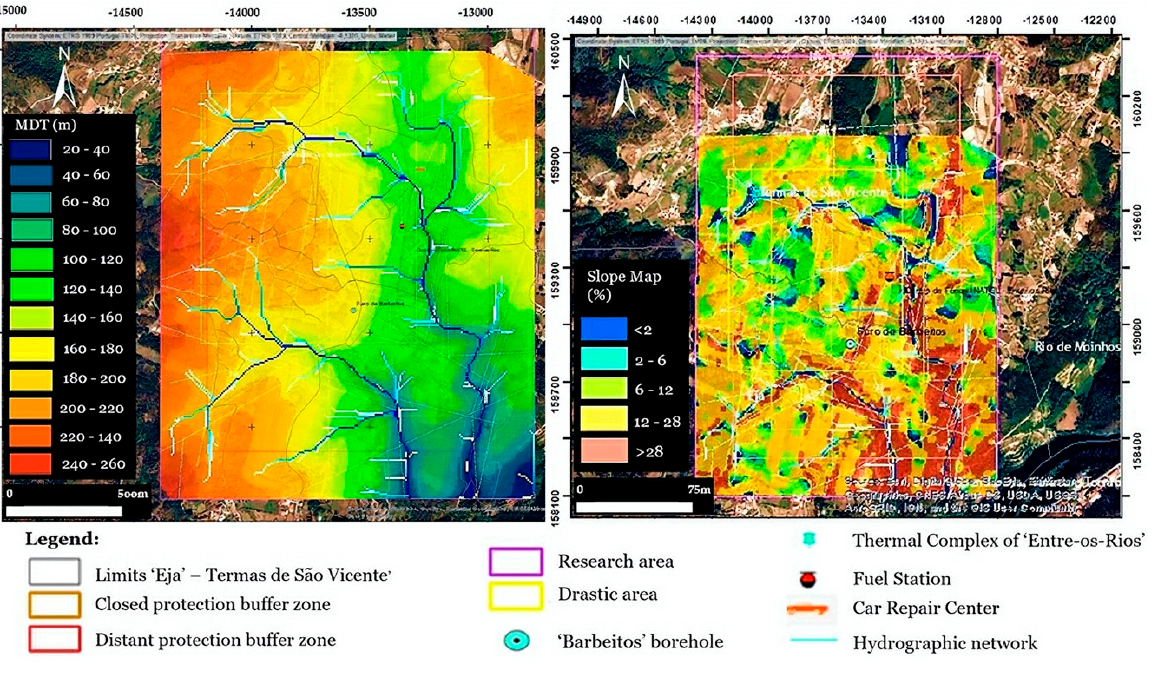
Figure 4. Regional geological outline map of the area surrounding the ‘Barbeitos’ borehole.